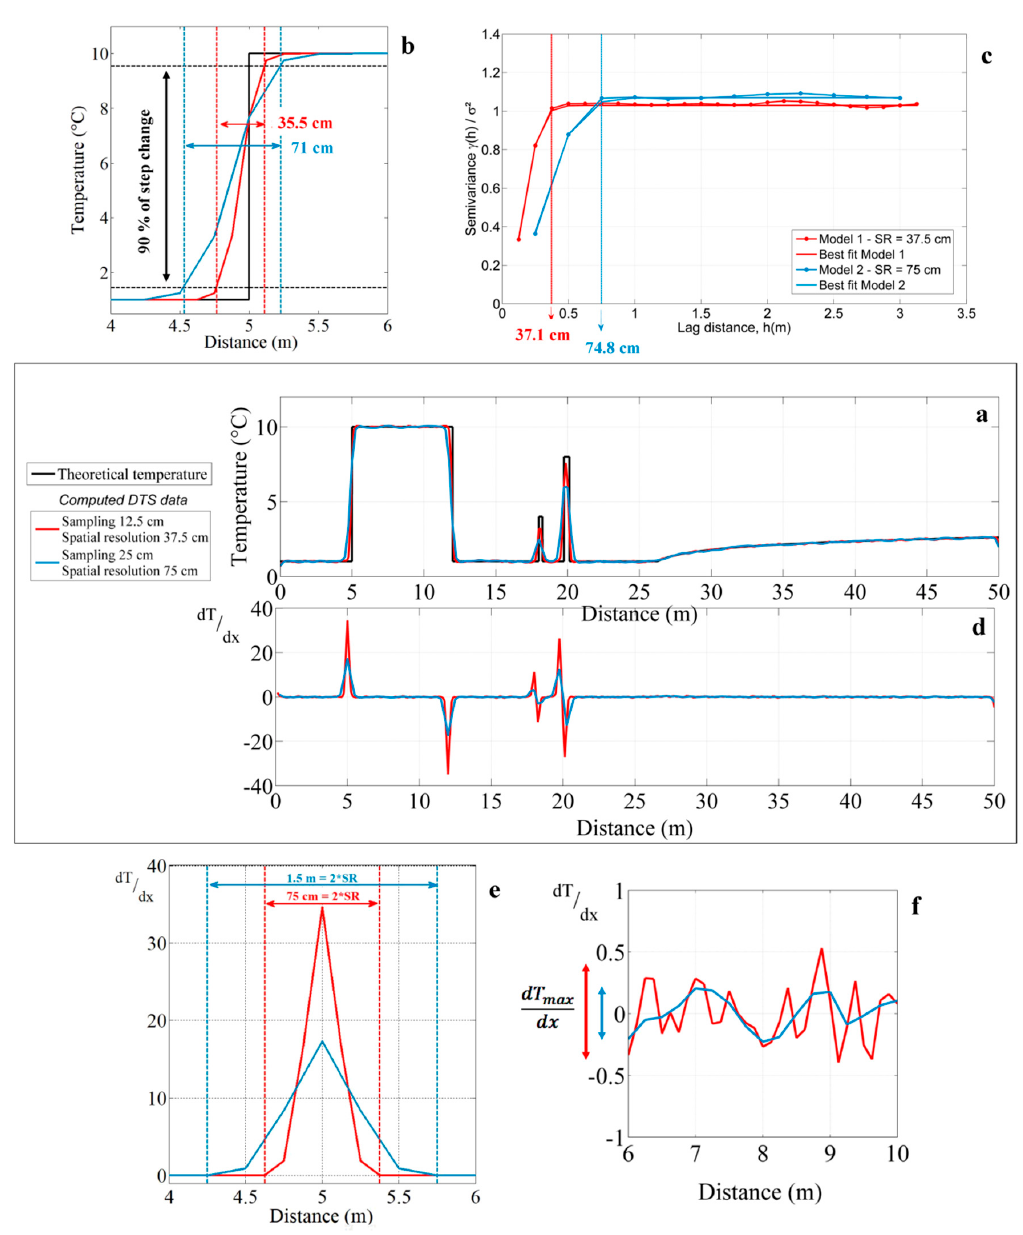
Figure 1. ( a ) Numerical modelling highlighting the impact of spatial resolution on Distributed Temperature Sending (DTS) measurements. The red and blue lines correspond to modelled temperature profiles and the black line to the synthetic temperature profile. ( b ) Estimation of the spatial resolution using the “90% step change” method. ( c ) Semivariograms computed from modelled temperature profiles using data between 6 and 11 m (step change). The spatial resolution can be estimated by fitting a Gaussian model on semivariograms (solid lines) and estimating the correlation length (range). ( d ) Derivative of the temperature estimated with respect to distance along the cable for both modelled temperature profiles. ( e ) Estimation of the spatial resolution using the derivative method applied on sections where a sharp step change occurs along the temperature profile. ( f ) Derivative calculations in constant and homogeneous sections of